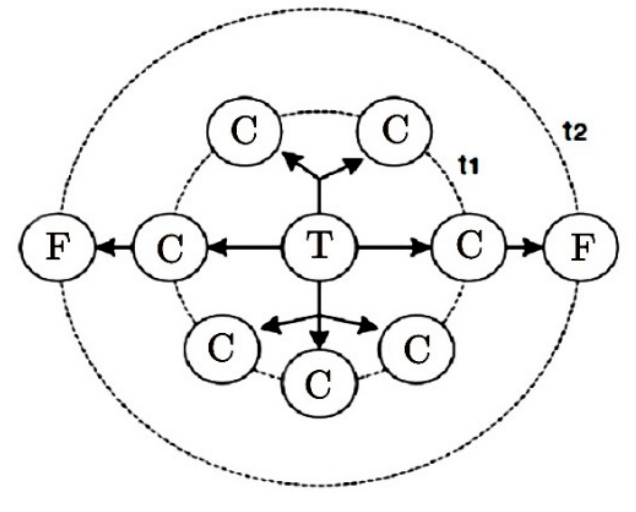
Figure 5. Example of a generic disassembly wave graph, with the target, components, and fasteners. Application of the 1st Method